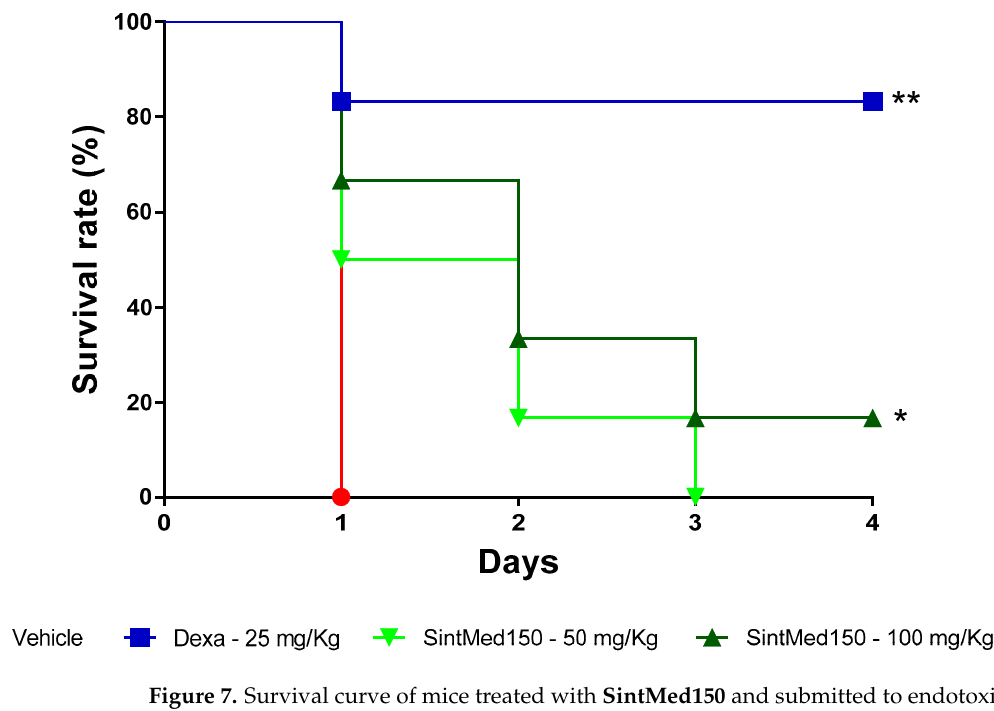
Figure 7. Survival curve of mice treated with SintMed150 and submitted to endotoxic shock. Mice were orally treated with SintMed150 at doses of 50 mg/kg ( ▼ ) and 100 mg/kg ( ▲ ), or dexamethasone at a dose of 25 mg/kg ( ■ ), or vehicle ( ● ). Survival was monitored for 4 days after LPS challenge. The results are from two experiments performed independently. * p < 0.05 compared to the vehicle group. ** p < 0.01 compared to the vehicle group. Statistical analysis was performed using Logrank (Mantel Cox).